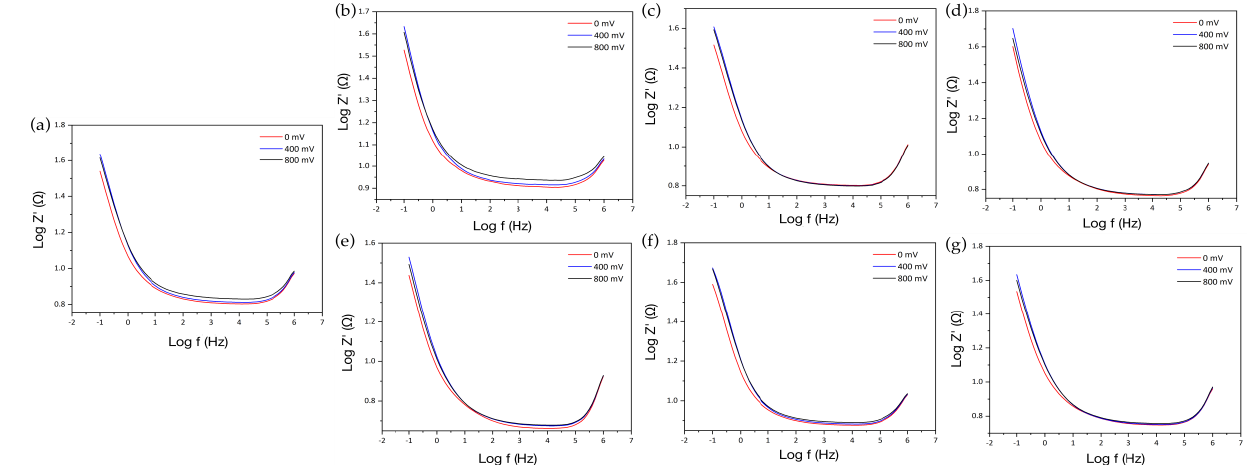
Figure 8. Bode plots between log 10 |Z| y log 10 f for the graphite electrode, treated SF w membranes with and without functionalization in Hank’s Balanced Salt solution at different DC electrical po- tentials. Where ( a ) Graphite electrode; ( b ) SF w obtained at 20 cm; ( c ) AgNPS-SF w ; ( d ) AuNPs-SF w ; ( e ) SF w obtained at 25 cm; ( f ) AgNPS-SF w ; ( g ) AuNPs-SF w .